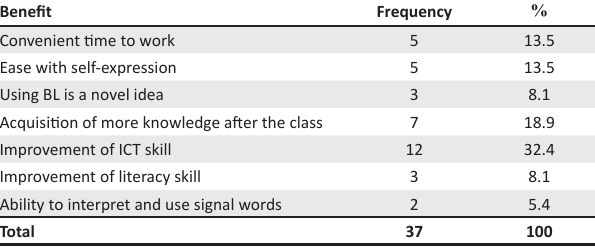
TABLE 2: Summary of students’ responses regarding the benefits of learning in a blended learning mode.